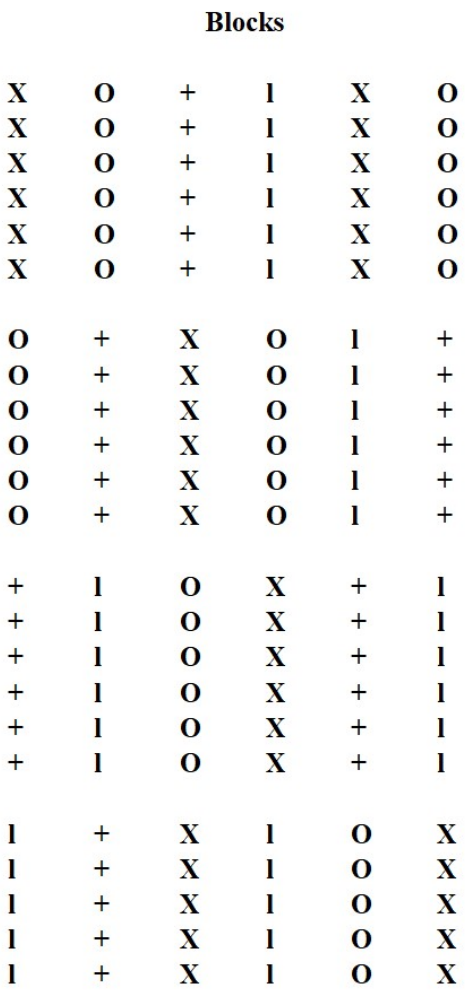
Figure 2. Distribution of 6 randomized blocks with 6 plants for each treatment (36 plants per treat- ment). Treatments: 0 ( O ), 125 ( l ), 250 ( + ) and 400 ( X ) mM hydrogen